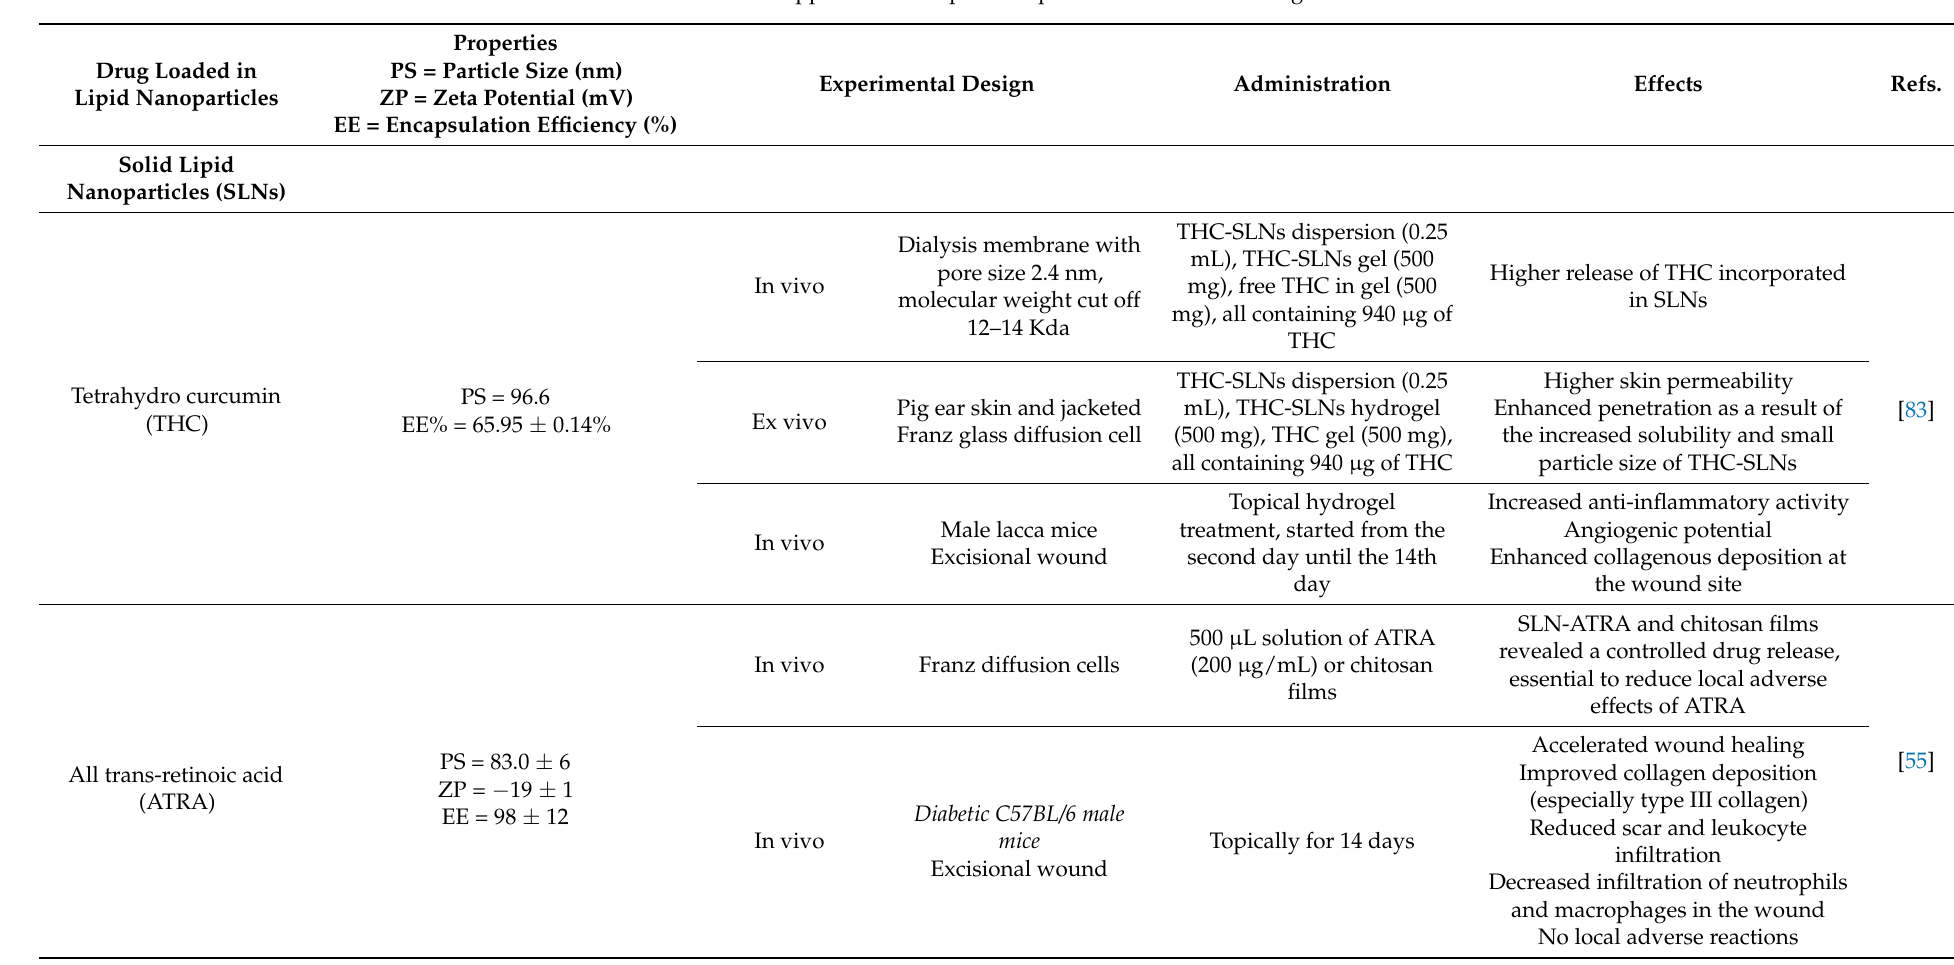
Table 2. Applications of lipid nanoparticles in wound